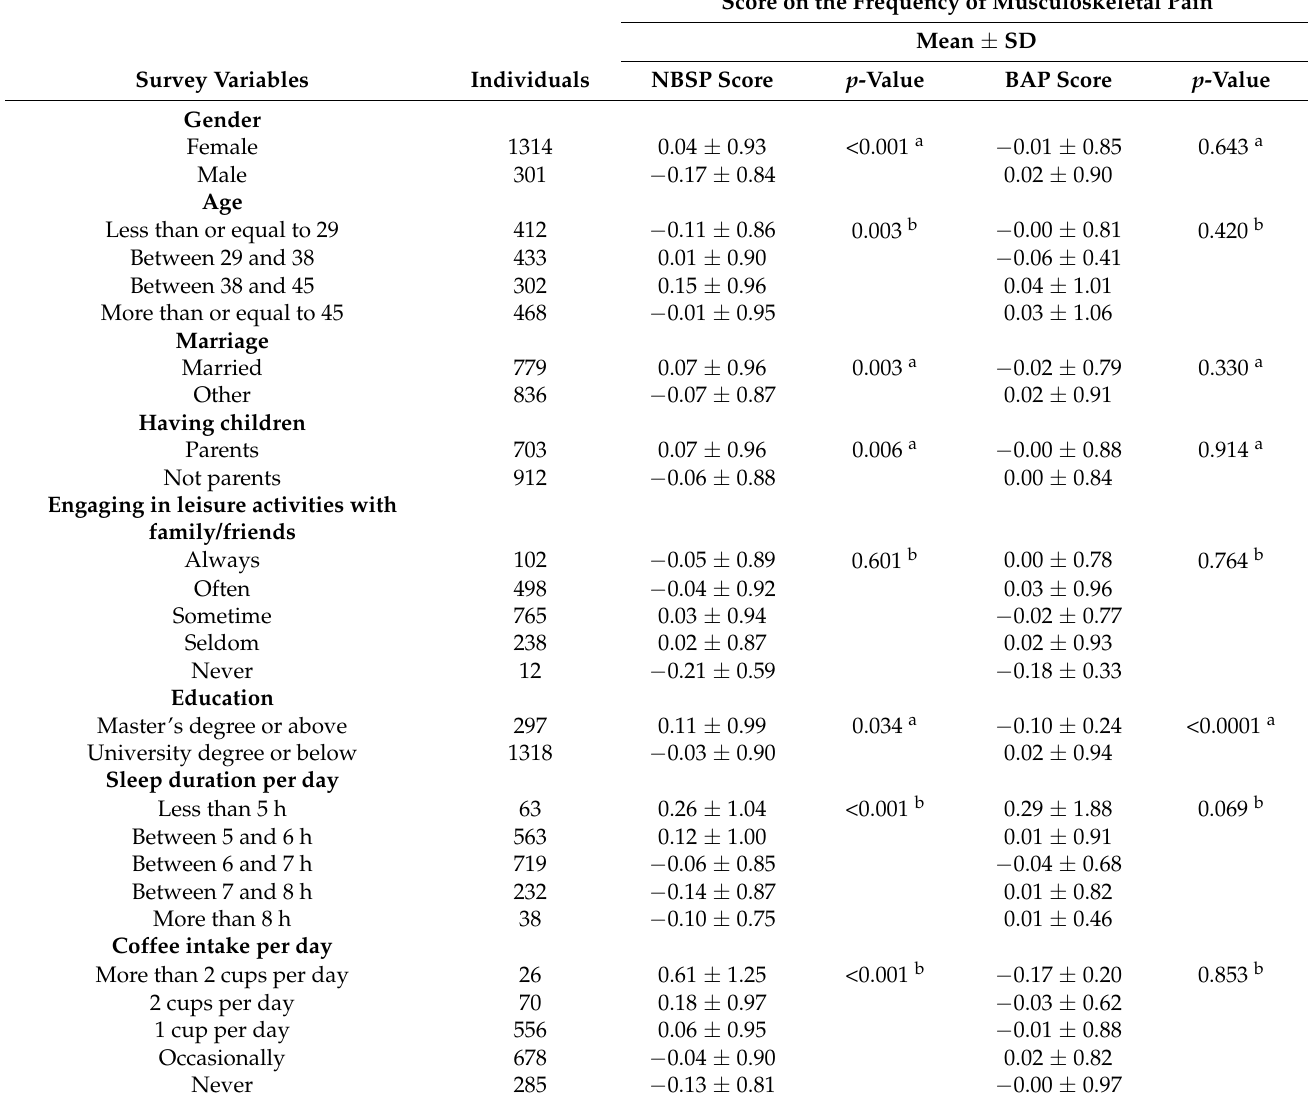
Table 2. Differences in the frequency of pain among the survey variables. Score on the Frequency of Musculoskeletal